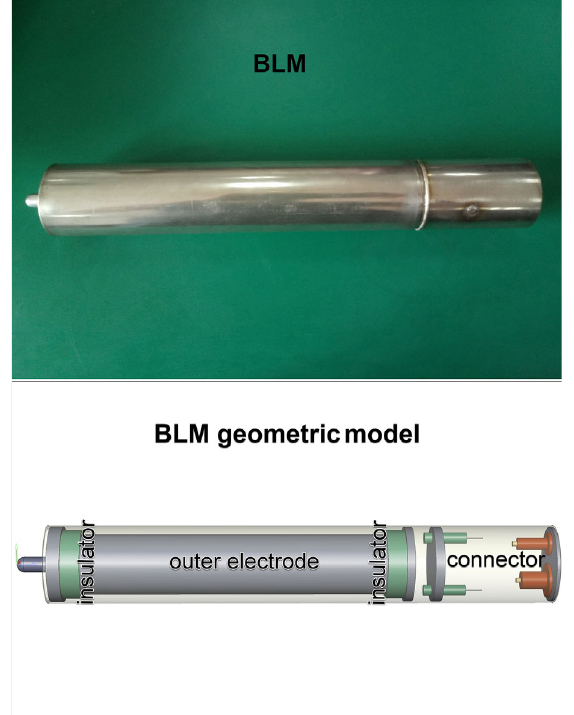
FIG. 2. The BLM used in CSNS and its geometric model implemented in FLUKA